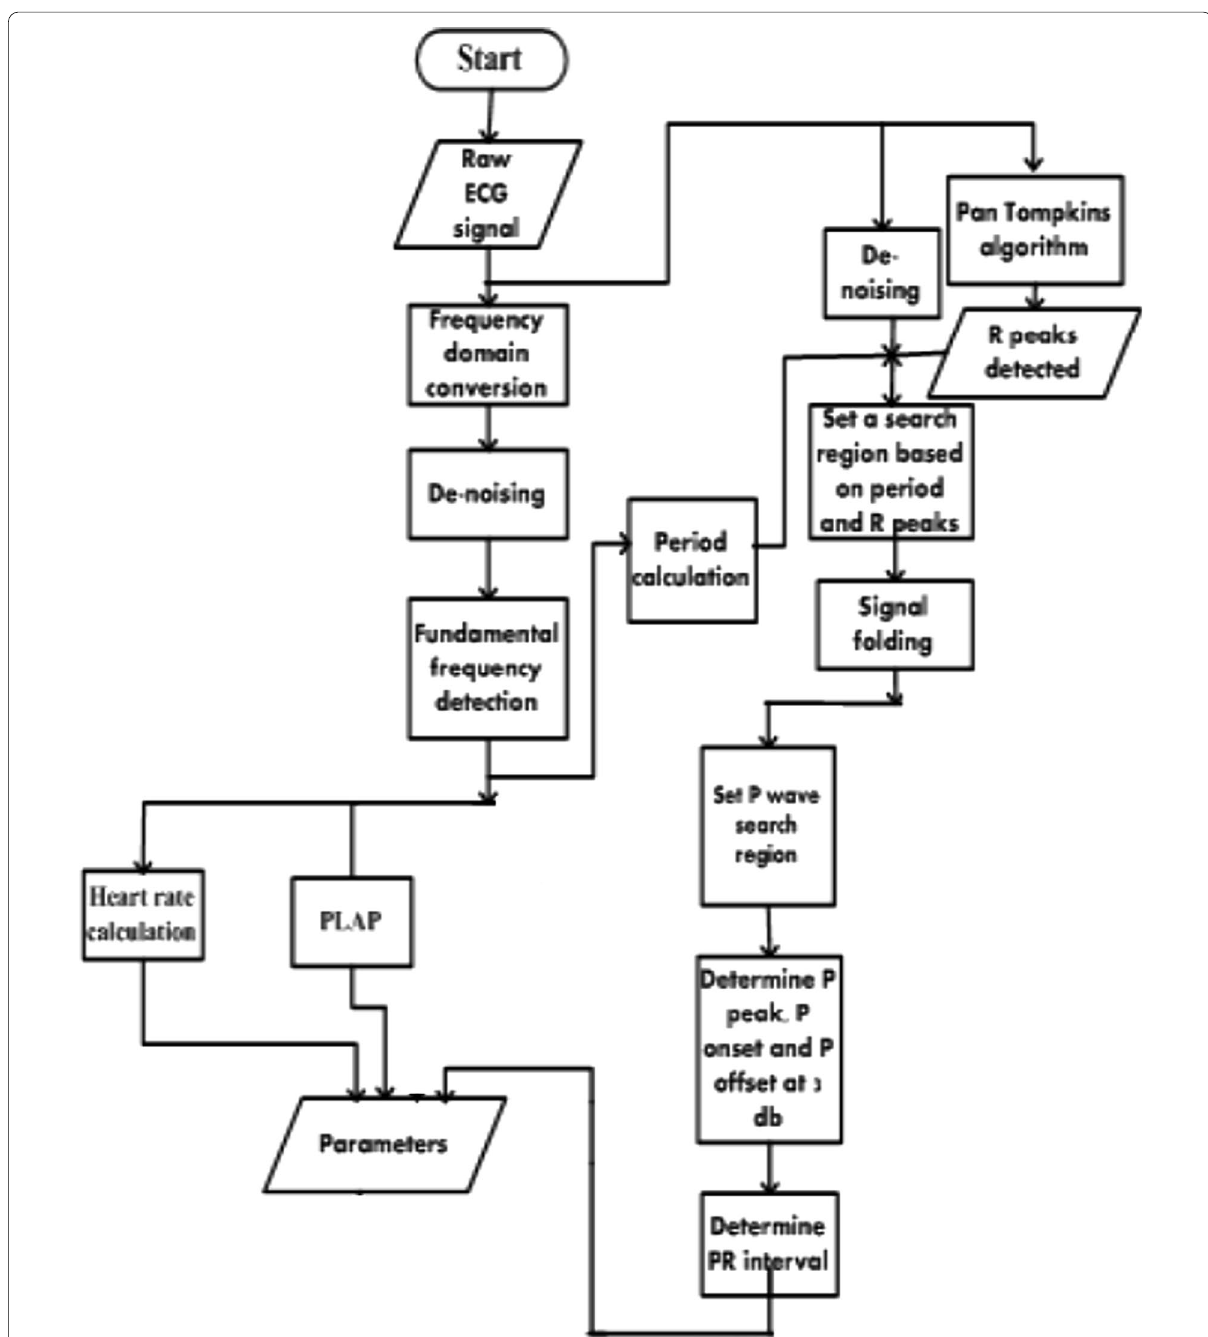
Fig. 5 Flowchart of Proposed Method: Figure shows complete flowchart of the proposed